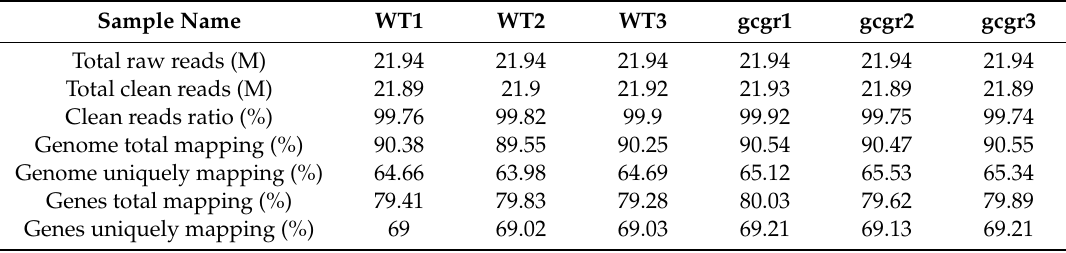
Table 1. Statistics for read filtering and